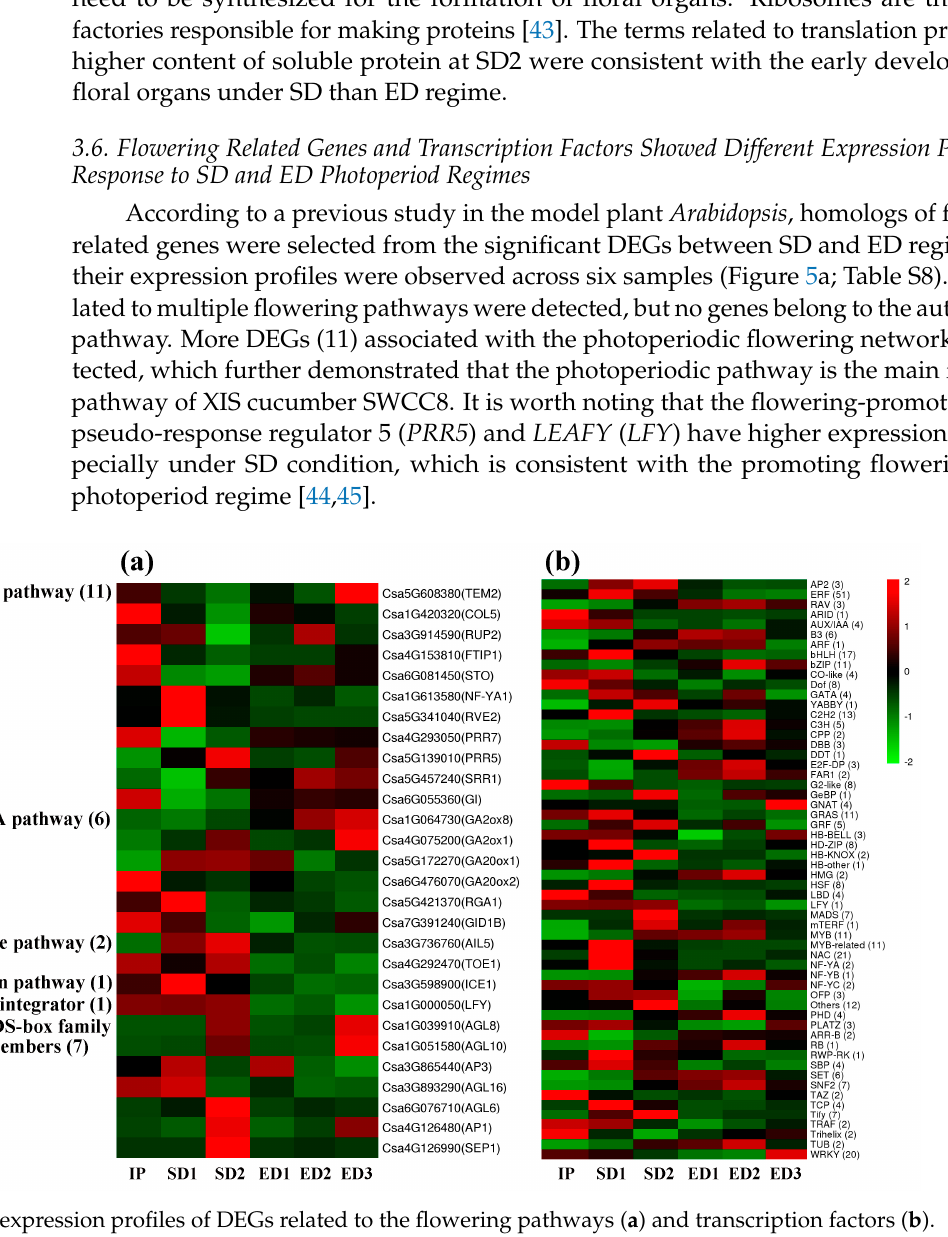
Figure 5. The expression profiles of DEGs related to the flowering pathways, ( a ) and transcription factors ( b ).